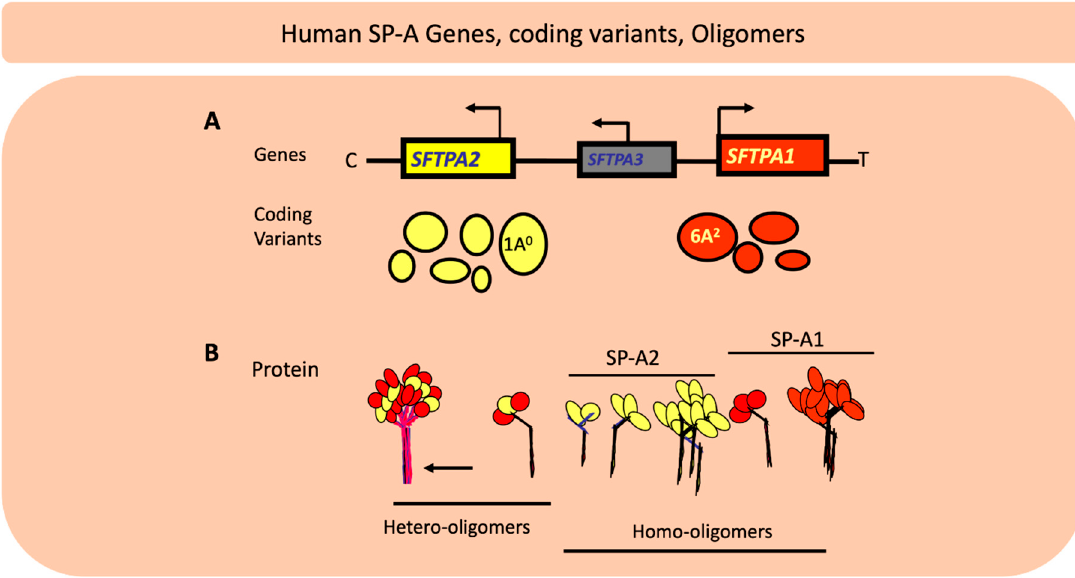
Figure 4. The chromosomal organization of SPFTPA locus consists of two functional genes the SFTPA2 encoding SP-A2 and the SFTPA1 encoding surfactant protein A (SP-A1) as well as a pseudogene, the SFTPA3 as shown in ( A ). The location of the centromere (C) and the telomere (T) are depicted. The transcriptional orientation is shown by a bent arrow. The two functional genes have opposite transcriptional orientation. The coding variants for each gene are shown below the relevant gene and the size of the circle denotes the frequency of each in the general population with the 1A 0 and 6A 2 being the most frequently observed variants. ( B ) depicts hetero-oligomers and homo-oligomers.